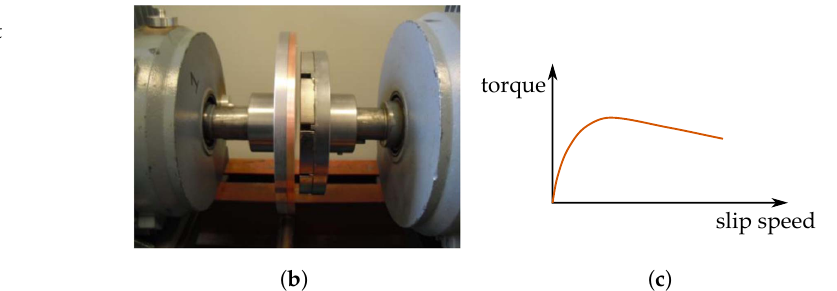
Figure 14. Eddy current coupler: ( a ) Illustration ( b ) Photograph [49]. ©IEEE. Reprinted, with permission, from Lubin, T.; Rezzoug, A. Steady-State and Transient Performance of Axial-Field Eddy-Current Coupling. IEEE Trans. Ind. Electron. 2015, 62, 2287–2296. ( c ) Torque vs. slip speed characteristics.